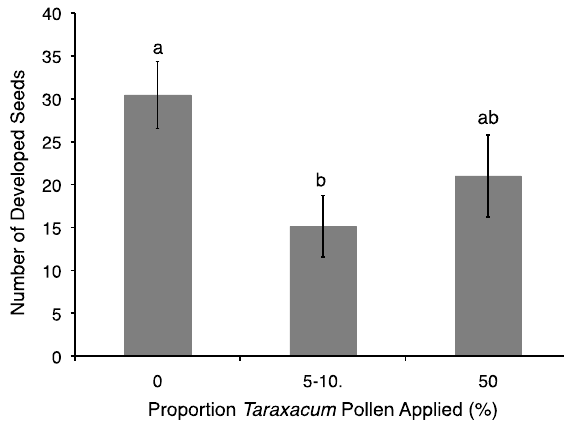
Figure 1. Seed set in Erythronium grandiflorum flowers when hand-pollinated with mixtures of conspecific and varying amounts of Taraxacum officinale pollen. Error bars represent standard errors. Different letters indicate significant differences between groups. n=25 for the 0% treatment group, n=22 for the 5-10% treatment group, and n=21 for the 50% treatment group.